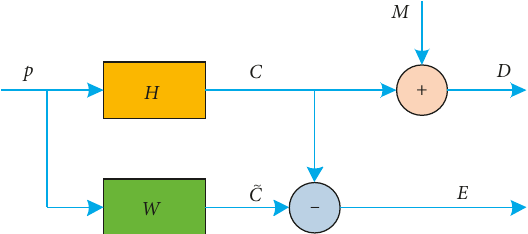
Figure 18: Single-cylinder combustion noise calculation